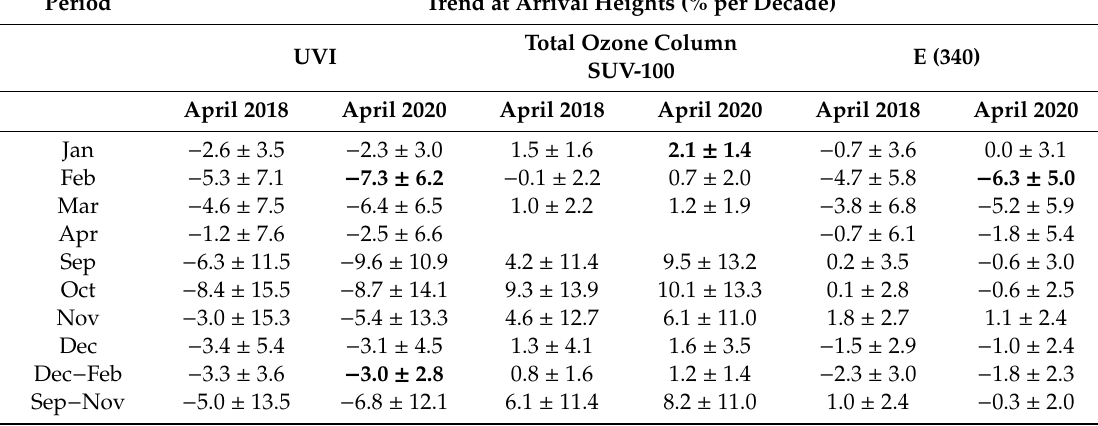
Table 5. Trends in UVI, TOC, and E(340) at Arrival Heights calculated either for the period January 1996–April 2018 (columns “Apr 2018”) as in the work by McKenzie et al. [14] or for the period January 1996–April 2020 (columns “Apr 2020”), which includes the period of the small ozone hole in the spring of 2019. UVI and E(340) trends were corrected with Method 3. Uncertainties of trends are provided at the 95% level. Trends that are statistically significant are indicated in bold